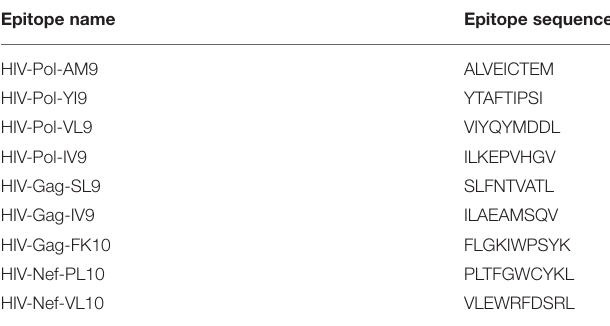
TABLE 1 | Name and sequence of HLA-A02 restricted epitopes used in the cell products